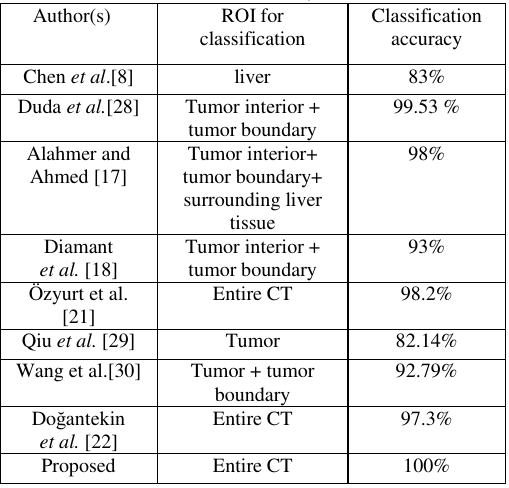
Table 3: Comparison of the proposed method with the existing methods for Classification Accuracy and ROI Selection